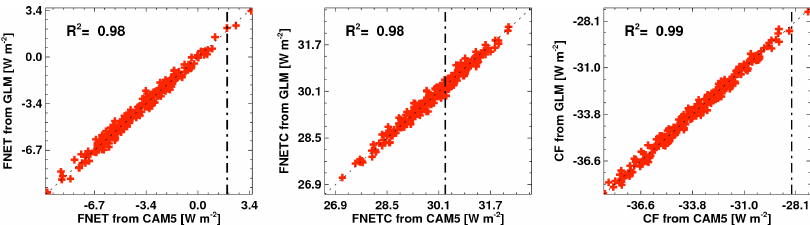
Figure 2 GLM-fitted response variables versus the CAM5 simulations for FNET, FNETC, and CF. The black dash lines represent the values simulated by CAM5 with default parameters.